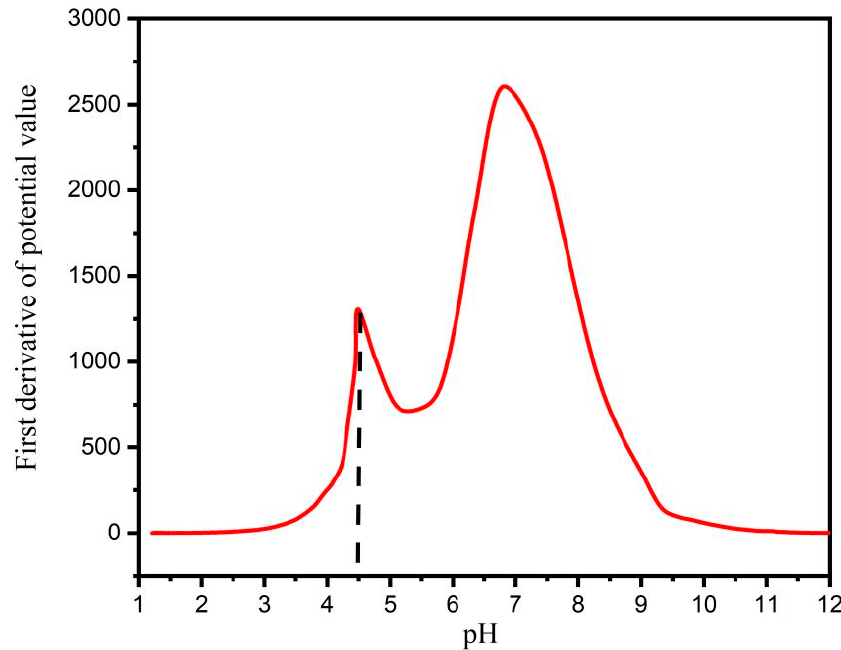
Figure 4. The first derivative of the fluorescent probe HTPAF solution (containing 0.1 mol/L HCl) titrated with 0.1 mol/L NaOH.